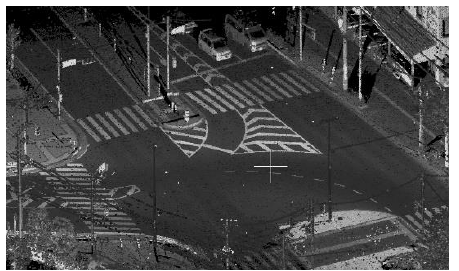
Figure 6. LiDAR data for evaluation of the developed vehicle- loading system